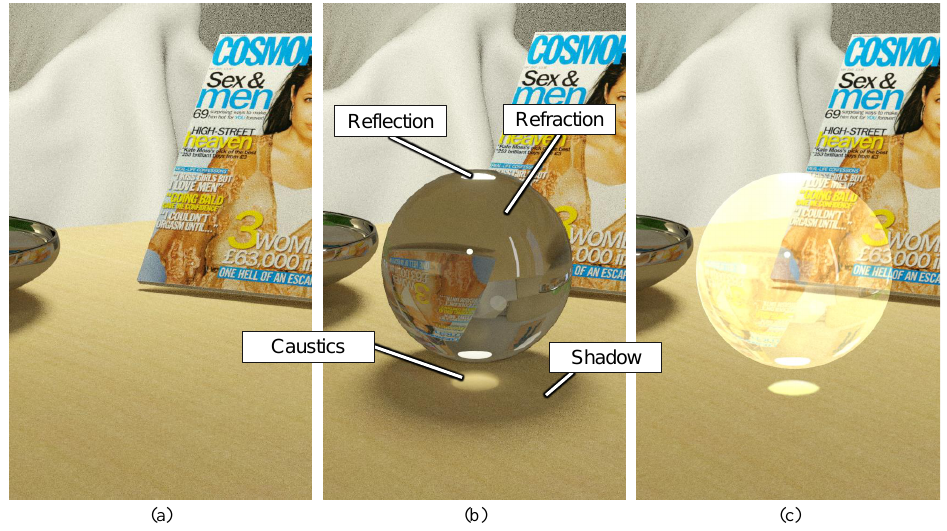
Figure 1. Results of representing a glass sphere as a virtual transparent object on different displays. ( a ) Real-world environment. ( b ) Result obtained using an ordinary display (capable of overwriting the real environment pixel-by-pixel). ( c ) Result obtained using a transmissive display (capable only of light transmission) such as an optical see-through head-mounted display